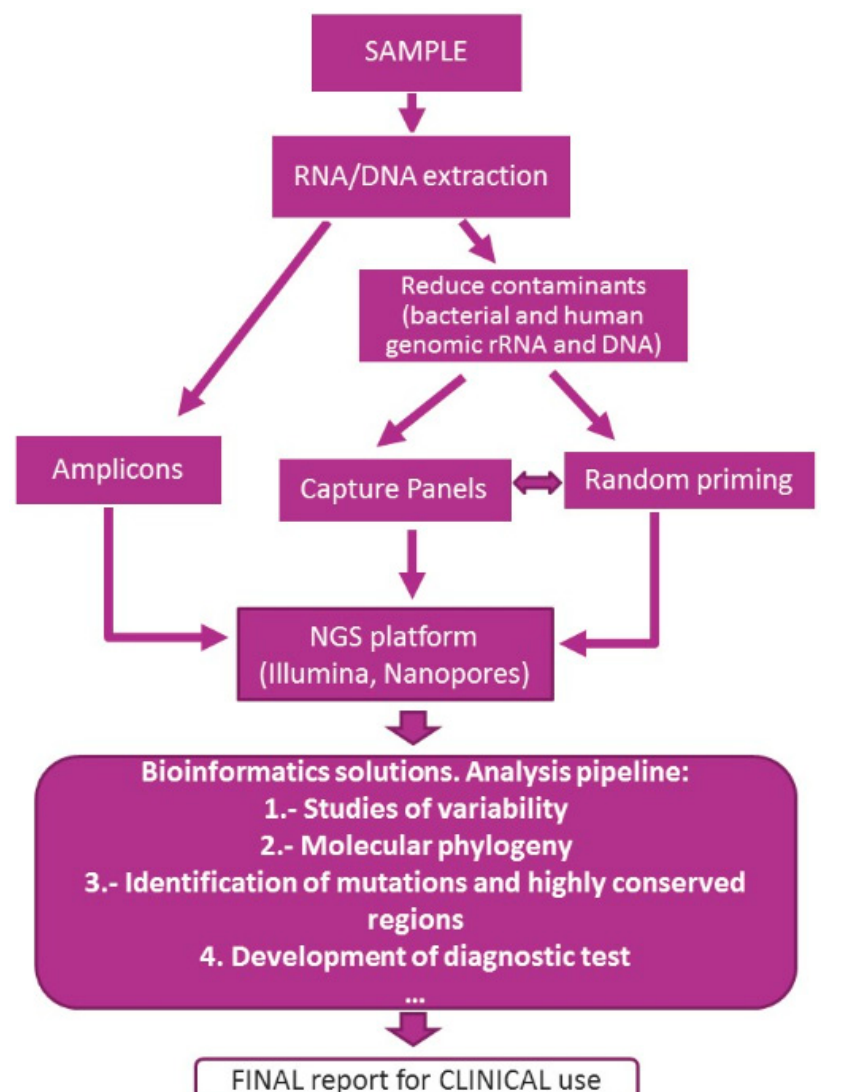
Figure 3. General schematic methodologies for virus genome